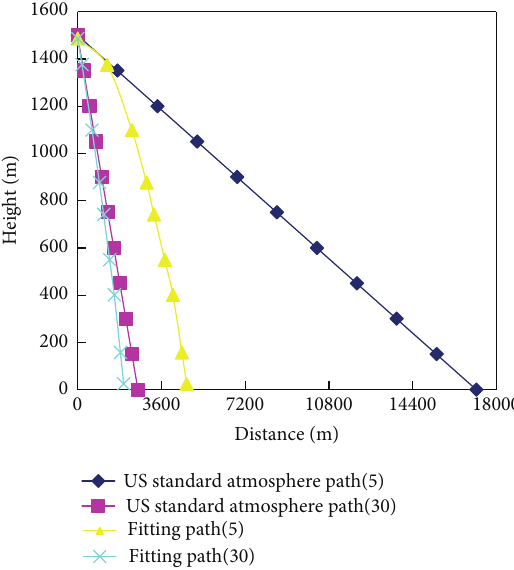
Figure 3: The propagation path of the radar beam in a super- refractive atmosphere during the airplane’s landing.